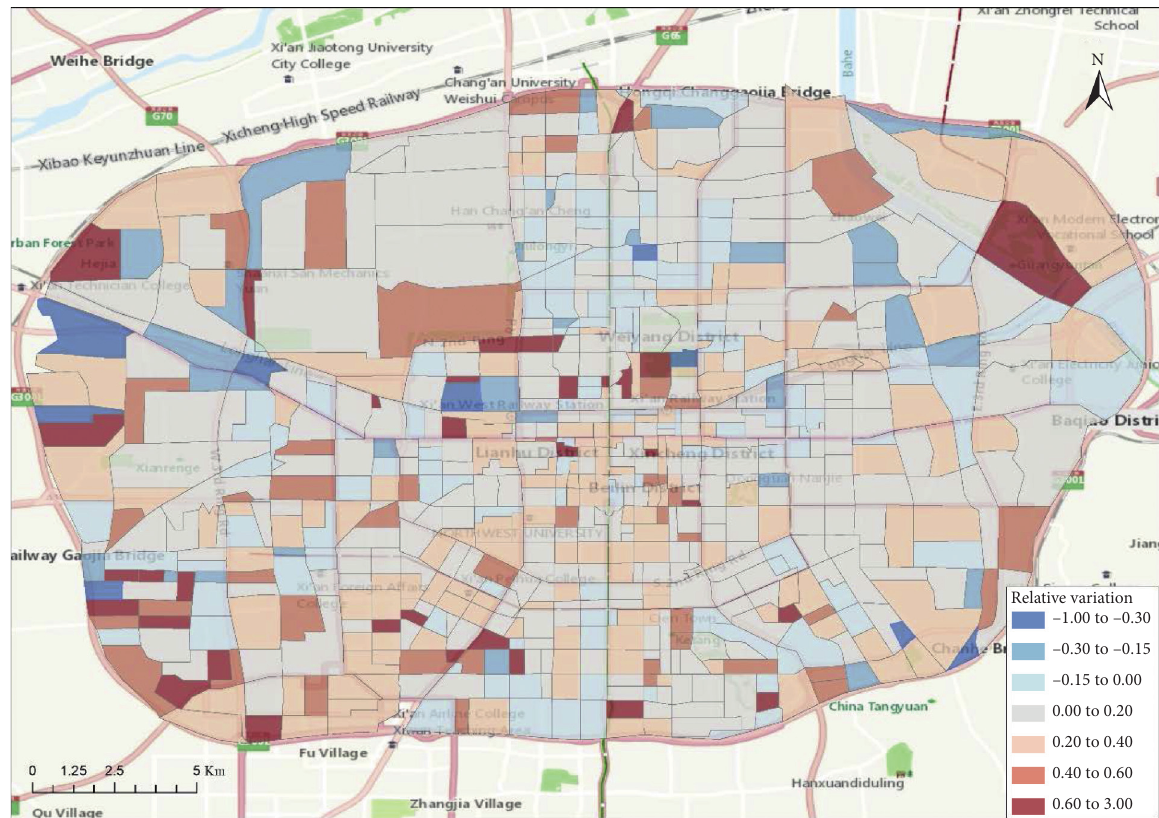
Figure 4: The relative variation of taxi ridership in